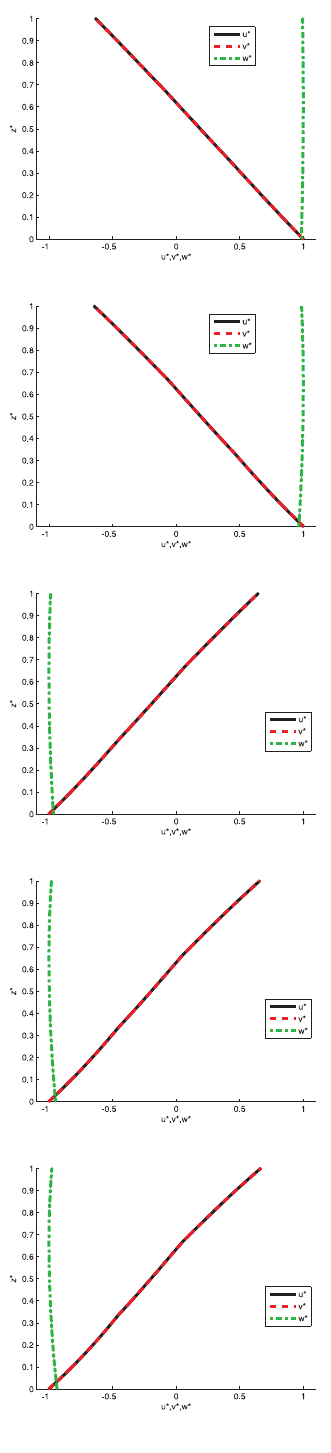
plates (a/h=20 or 10) for each frequency investigated (from the first to the tenth). The simple 2D kinematic model em-